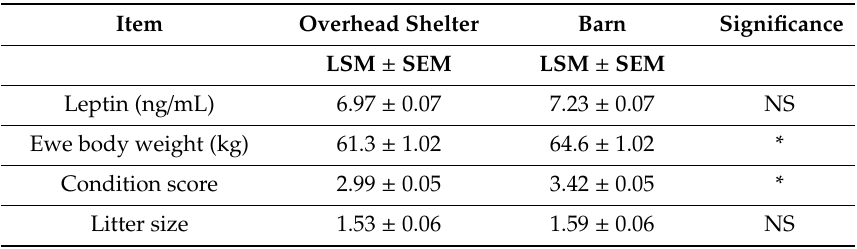
Table 1. The plasma leptin concentration, ewe body weight, body condition score and litter size of ewe kept under the overhead shelter and in the barn.